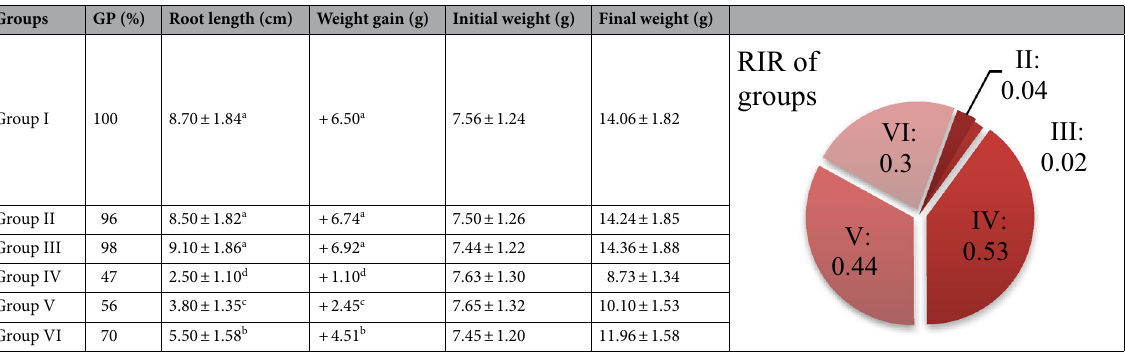
Table 1. The effects of KBrO 3 and GSE on physiological parameters. Group I: Control, Group II: 465 mg/L GSE, Group III: 930 mg/L GSE, Group IV: 100 mg/L KBrO 3 , Group V: 100 mg/L KBrO 3 + 465 mg/L GSE, Group VI: 100 mg/L KBrO 3 + 930 mg/L GSE. Values are shown as mean ± SD. 50 bulbs were used for germination percentage and 10 bulbs were used for root length and weight gain. The averages shown with different letters (a-d) in the same column are significant at p < 0.05. GP: germination percentage, RIR: relative injury